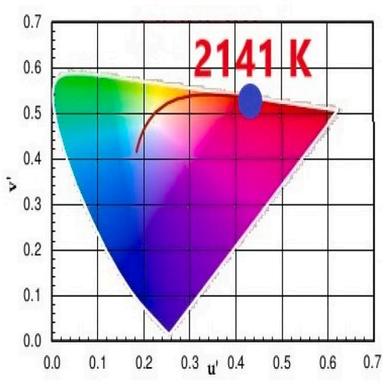
CCT coordinates (u' and v') with the respective CCT value of the optimal nanophosphor Ba2La3.8Eu0.2Zn2O10.